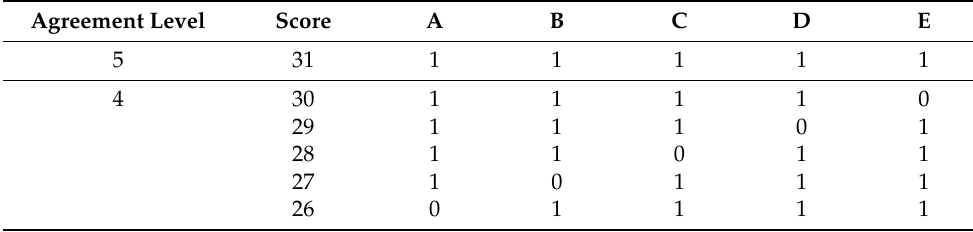
Table 3. The ranking scoring table for five groups of input